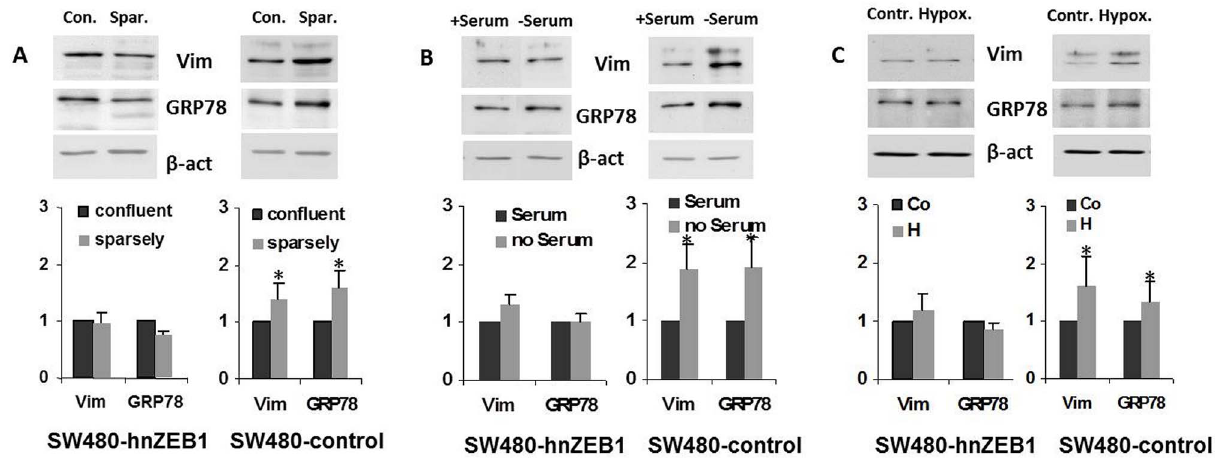
Figure 2. EMT is a prerequisite for ER-stress under conditions of sparse growth, serum starvation and hypoxia. A . SW480-shZEB1 clones show neither EMT indicated by low amounts of vimentin nor ER-stress indicated by low amounts of GRP78 under growth conditions that favor epithelial (confluent: con.) or mesenchymal (sparsely: spar.) growth conditions compared to SW480-control cells. B . SW480-shZEB1 clones do not develop EMT or ER-stress under conditions of stress induced by starvation (6 h- serum) compared to SW480-control cells. C . SW480-shZEB1 clones do not develop EMT or ER-stress under hypoxia-like conditions (6 h; serum free; 100 m M CoCl 2 ) compared to SW480-control cells. Data shown is the mean 6 SD from three independent experiments; * : p # 0.05.